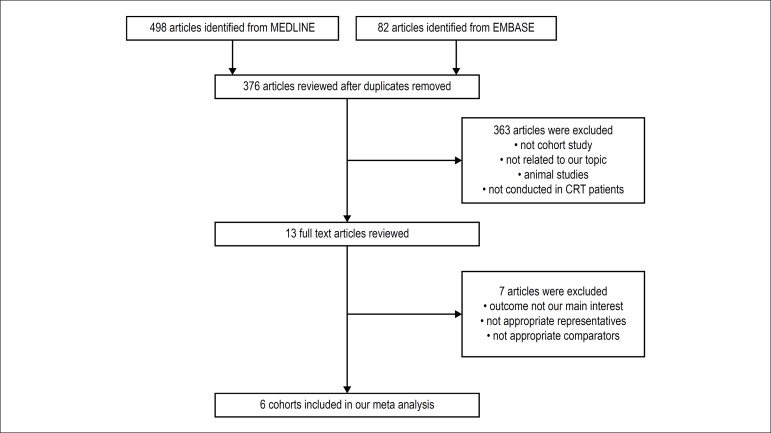
Search methodology and selection process.